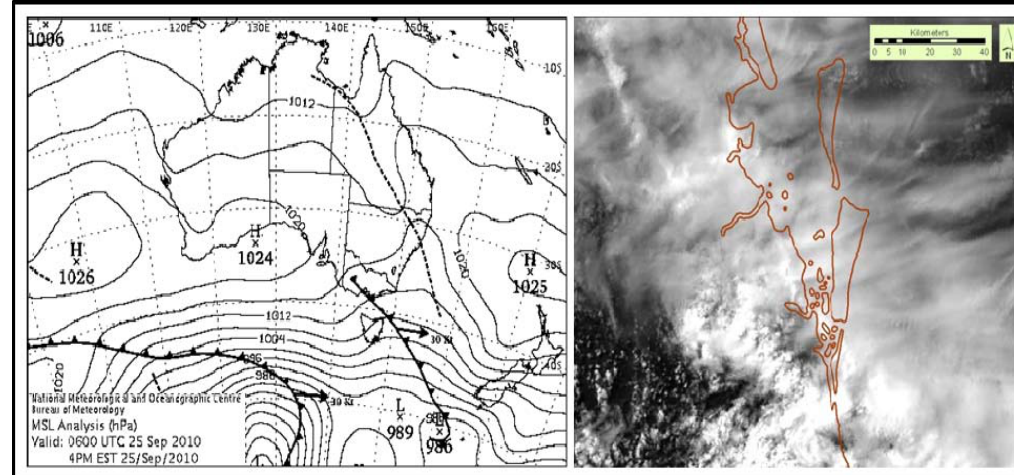
Figure 3. MSLP chart for 06:00, MODIS band 1 image 03:40 UTC, September 25,